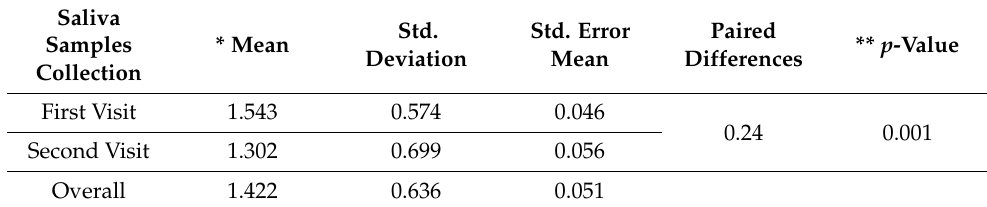
Table 1. Cortisol levels in saliva at different time intervals for the participating students (N-151).